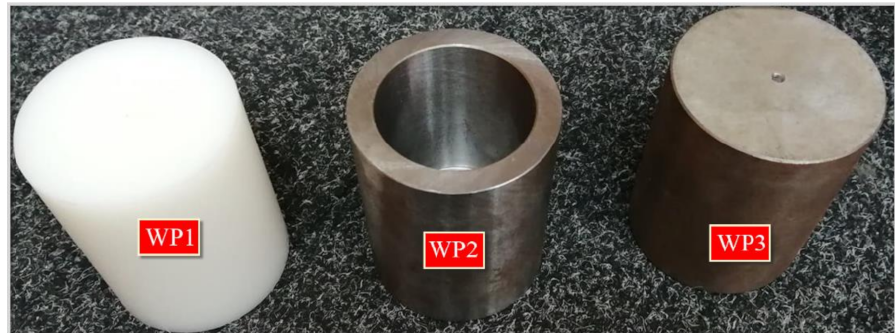
Figure 2. The three types of